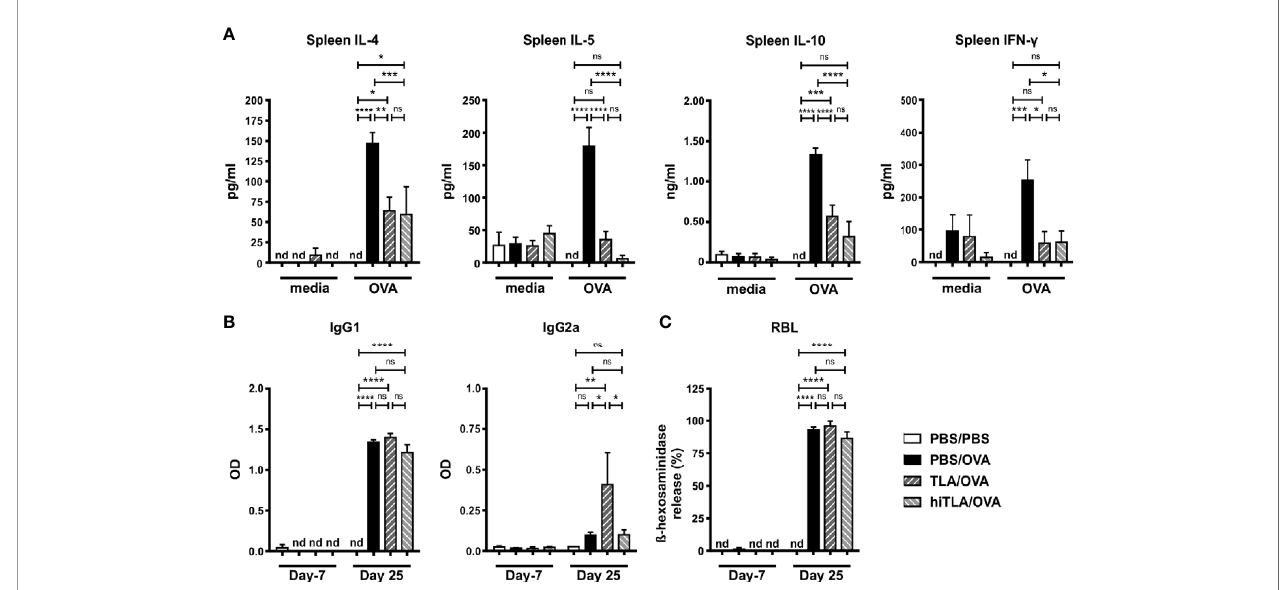
FIGURE 5 | Therapeutic treatment with native or heat-inactivated TLA reduces systemic type 2 responses. (A) Levels of IL-4, IL-5, IL-10, and IFN- g after medium and ovalbumin (OVA) restimulation of spleen cells from mice treated as in Figure 4A . (B) Levels of OVA-speci fi c antibodies IgG1 and IgG2a in serum collected at the beginning and at the end of the experiment. (C) Release of b -hexosaminidase by rat basophil leukemia (RBL) cells. Graphs show results from 1 representative experiment from 2 independent experiments with 5 mice per group. Error bars show mean ± SEM. nd , not detectable; TLA , tachyzoites lysate antigen; hiTLA , heat-